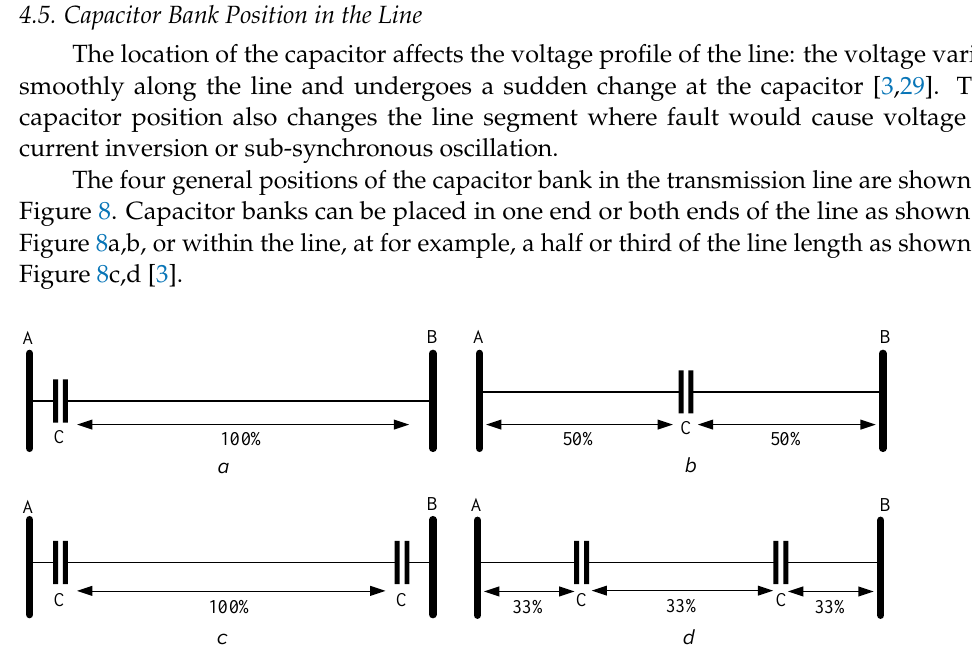
Figure 8. Common capacitor bank positions in transmission line ( a ) one end, ( b ) mid-line, ( c ) both ends and ( d ) one third of line length on both